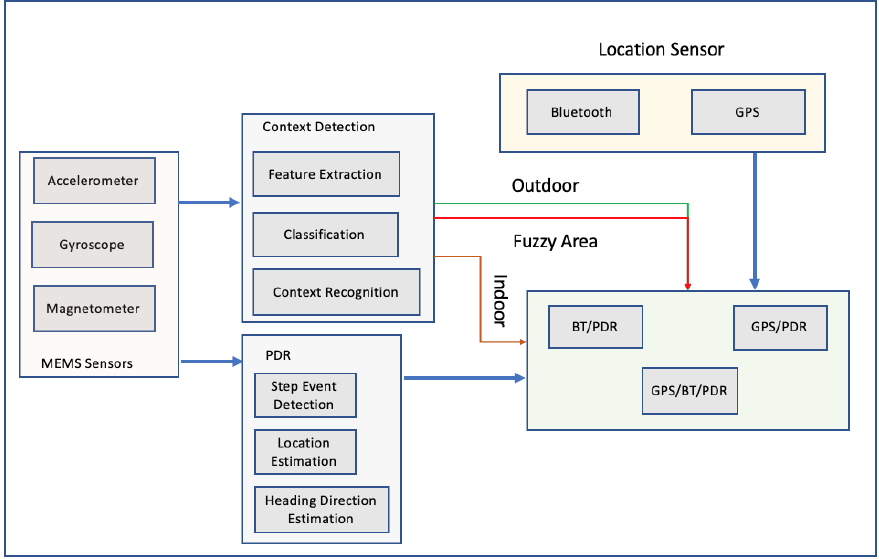
Figure 9. A GPS/Bluetooth/Pedestrian Dead Reckoning system design presented in Reference [50].